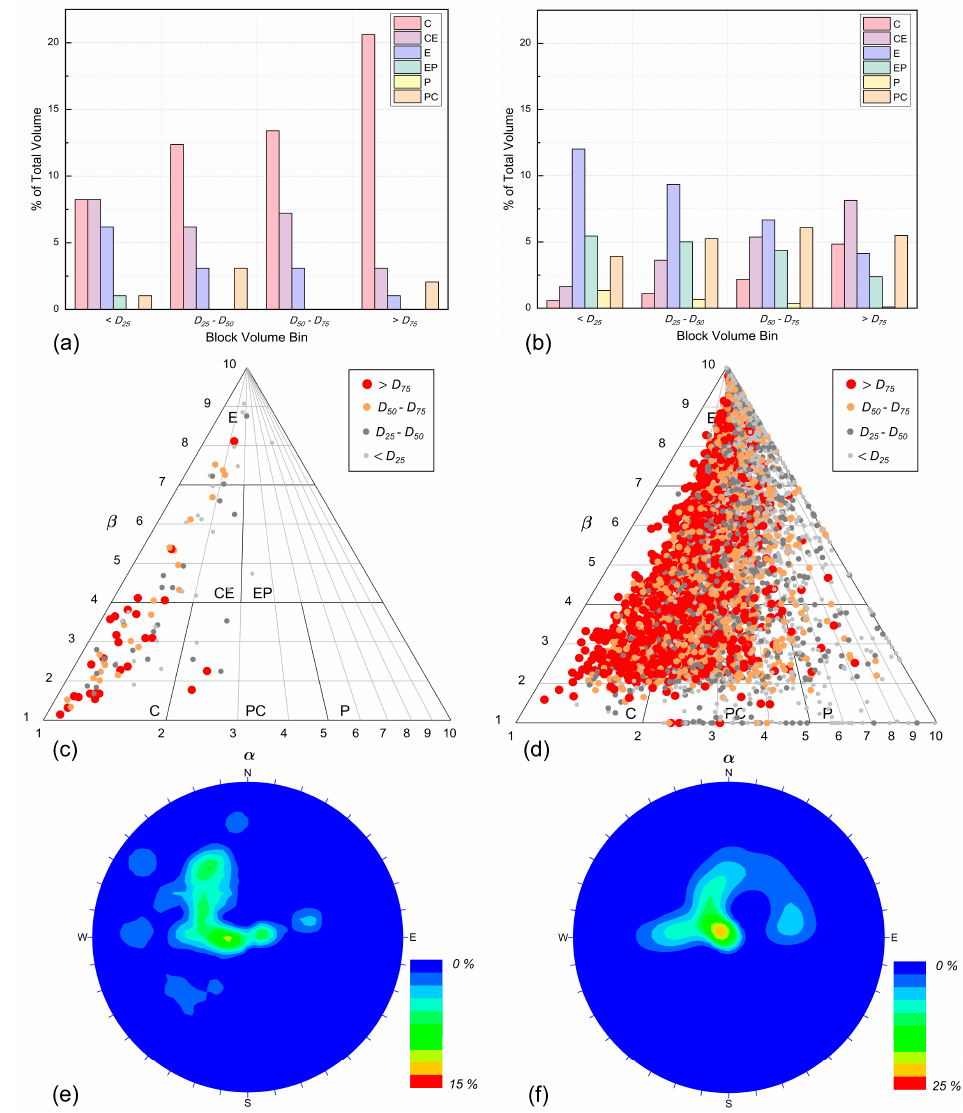
Figure 14. The shape distribution and block volume ranges obtained from PCM-DDN ( a ) and PCM- SDS ( b ) for Site 1. The block shape distribution from PCM-DDN ( c ) and PCM-SDS ( d ) for Site 1. The block orientation distribution from PCM-DDN ( e ) and PCM-SDS ( f ) for Site 1.